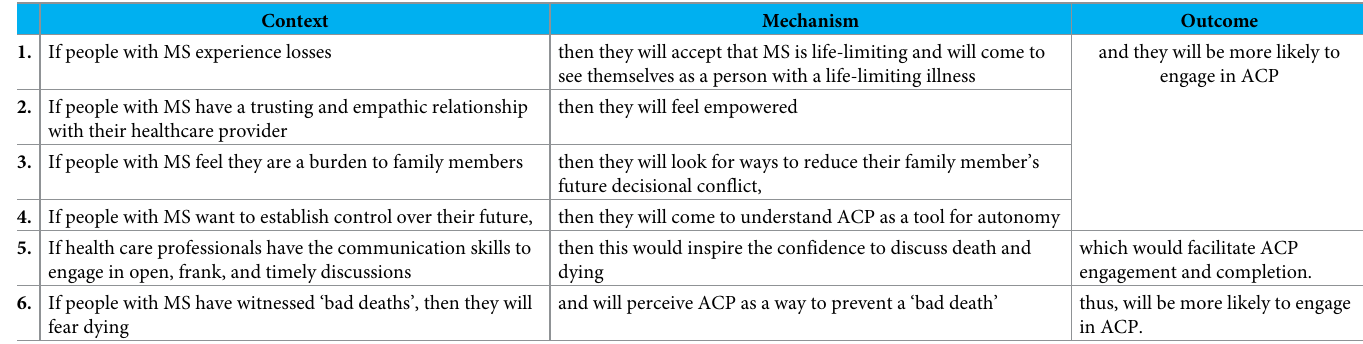
Table 2. ‘Context-mechanism-outcome’ hypotheses.